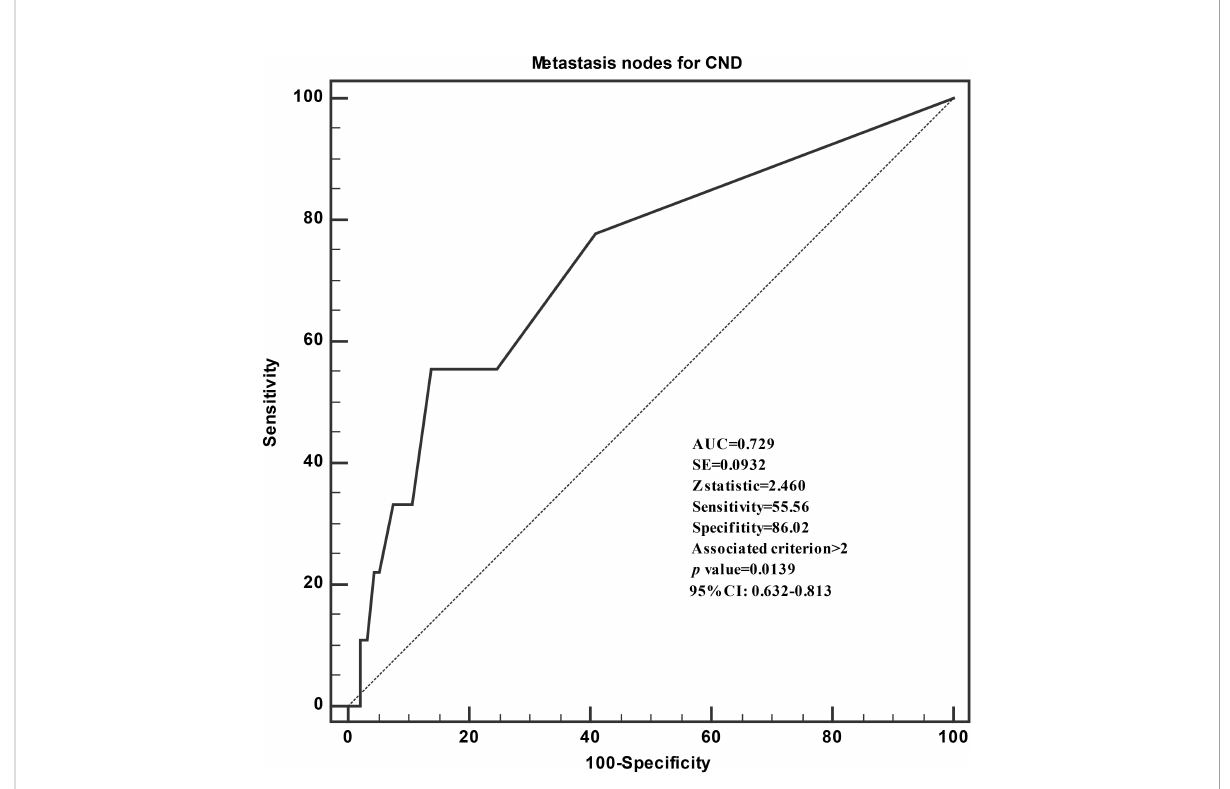
FIGURE 1 Receiver operating characteristic curve analyses of the numbers of lymph nodes metastases for predicting recurrence.